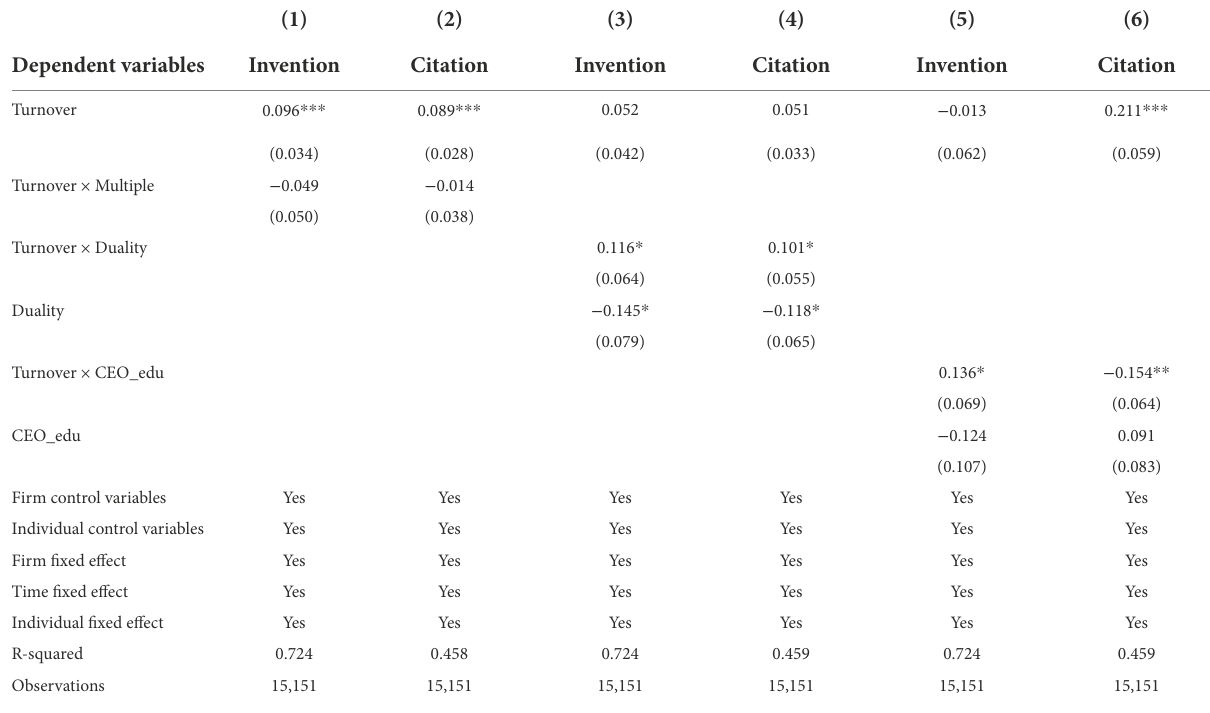
TABLE 4 Heterogeneity effects of CEO